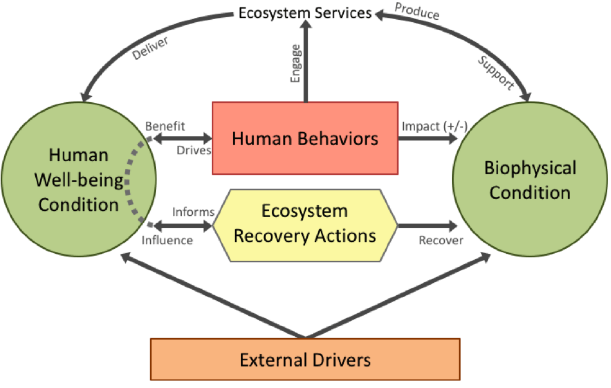
Fig. 1 . Integrated conceptual model of Puget Sound restoration adopted by the Puget Sound Partnership.